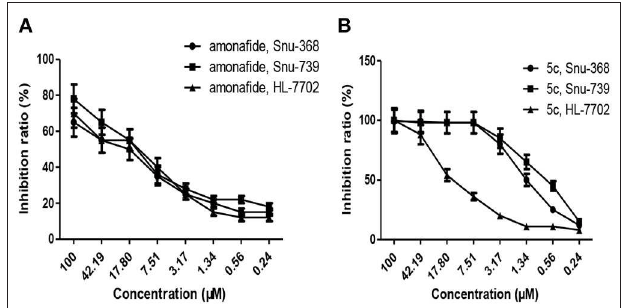
FIGURE 2 | Inhibition ratio of amonafide (A) and 5c (B) on cancer cells (Snu-368 and Snu-739) and the matched normal cells (HL-7702) with 10 µ M of tested complexes.